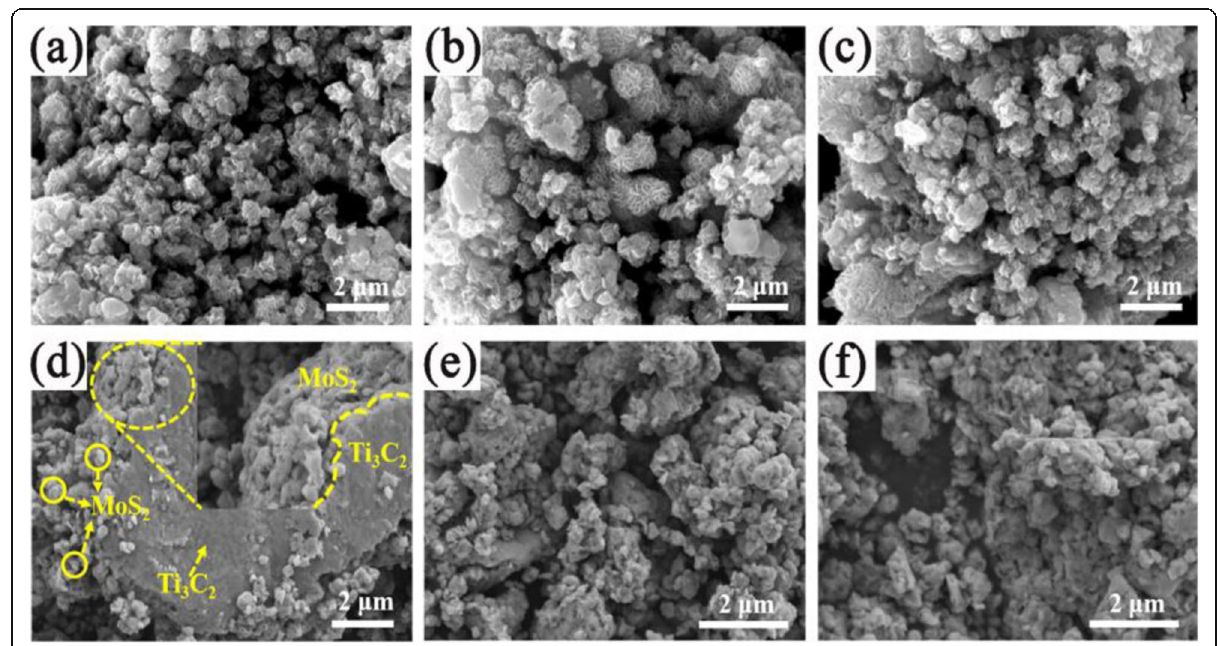
Fig. 2 FESEM images of a TM0, b TM0.1, c TM0.3, d TM0.5, e TM1, and f